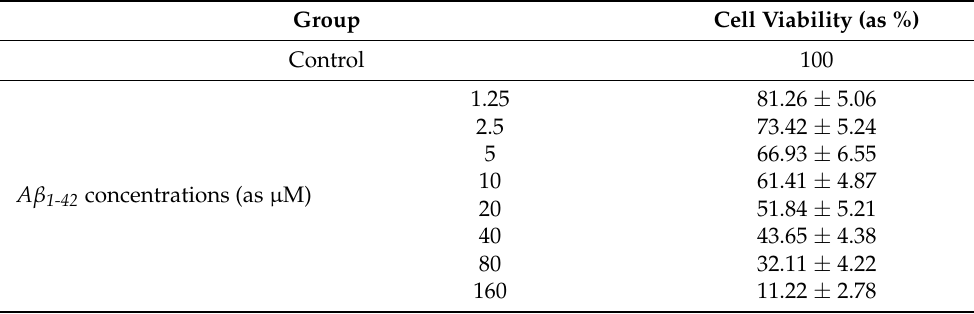
Table 1. Cytotoxicity of A β 1-42 on differentiated SH-SY5Y cells.